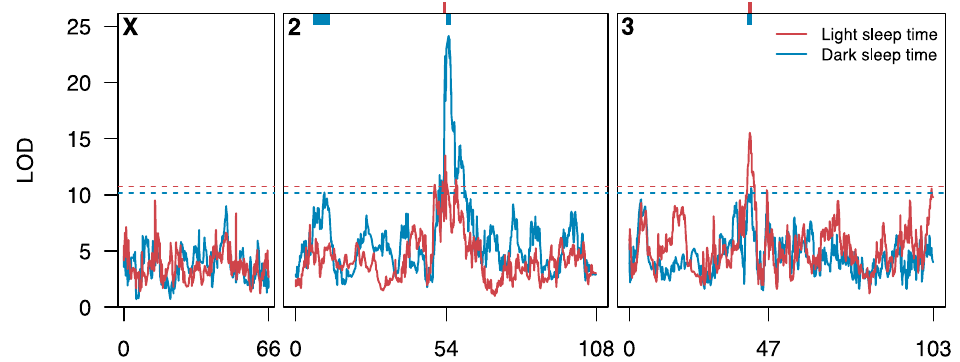
Figure 3. Quantitative Trait Loci (QTL) identified for sleep time in the DSPRF1. Each curve shows a genome scan for loci affecting sleep time in the light (red) or dark (blue). Genetic positions 54 and 47 on chromosomes 2 and 3, respectively, represent the positions of centromeres. The horizontal dashed lines represent genomewide 5% permutation thresholds (light: LOD = 10.7, dark: LOD = 10.1). The colored bars at the top of the plot represent the 3-LOD drop intervals of the five QTL mapped for sleep time.